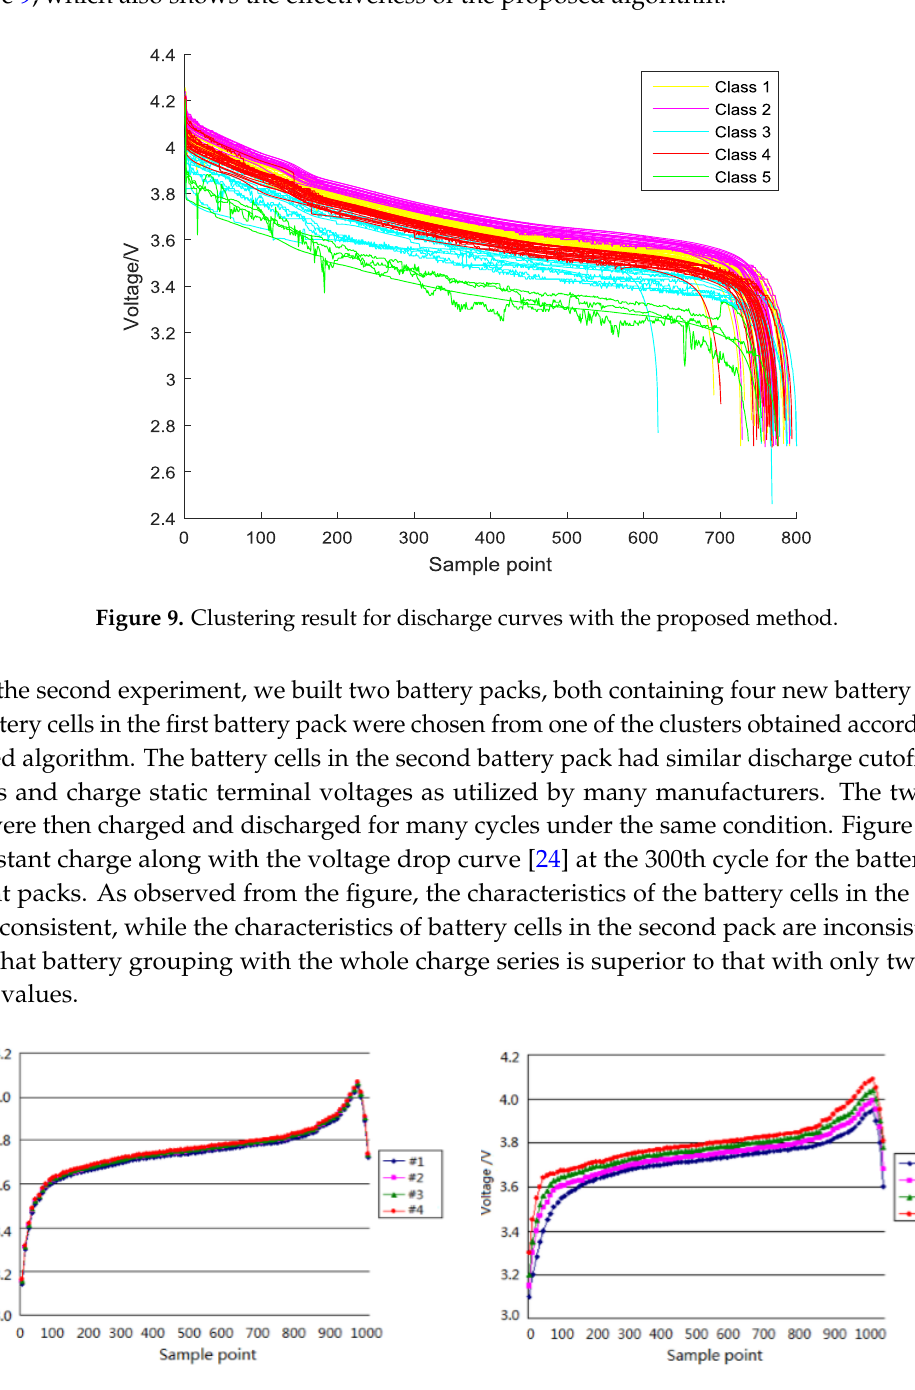
Figure 10. Constant charge along with the voltage drop characteristics of battery cells for two different battery packs; ( a ) cells grouped with similar charge curves; ( b ) cells grouped with similarterminal.